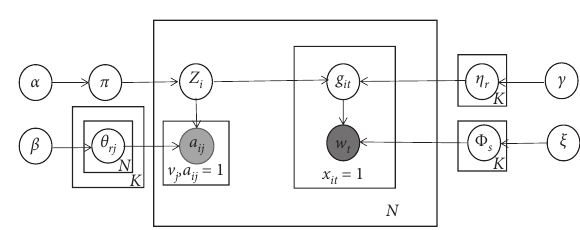
Figure 1: The graphical representation of